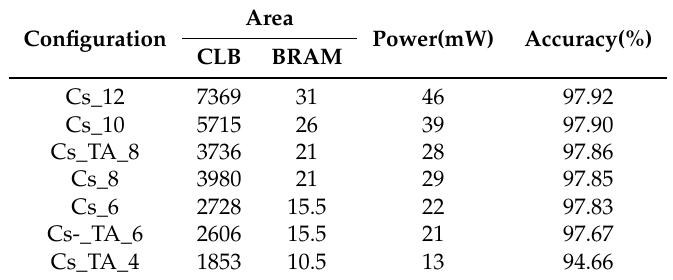
Table 4. Area, Power and accuracy results for MNIST